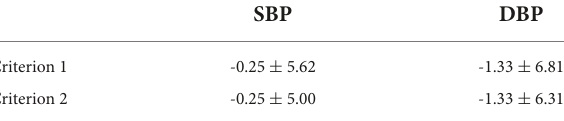
TABLE 2 Validation results in accordance with Criterion 1 and Criterion 2 of the guidelines.